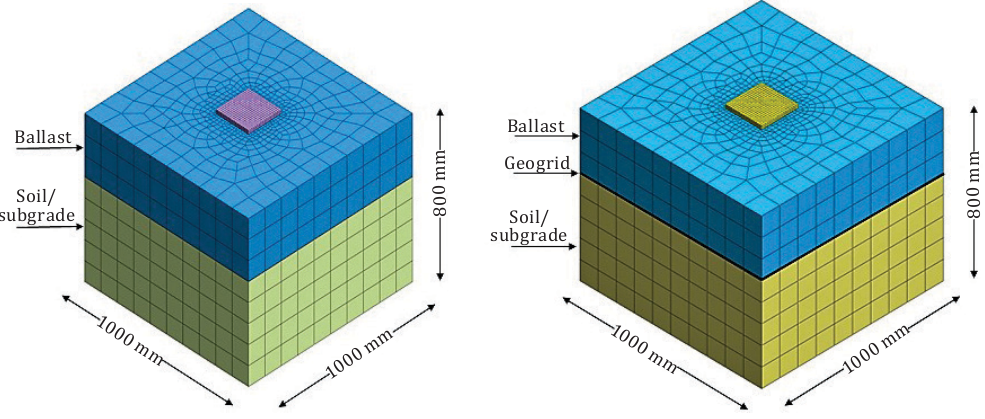
b) with geogrid in absence of blanket Figure 7. Numerical model representing subgrade and ballast